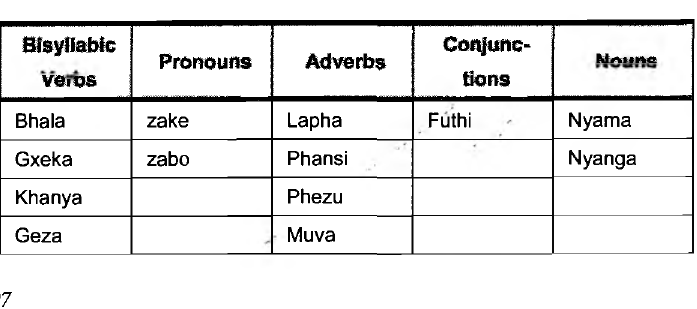
Table 2: Examples of bisyllabic words according to their different